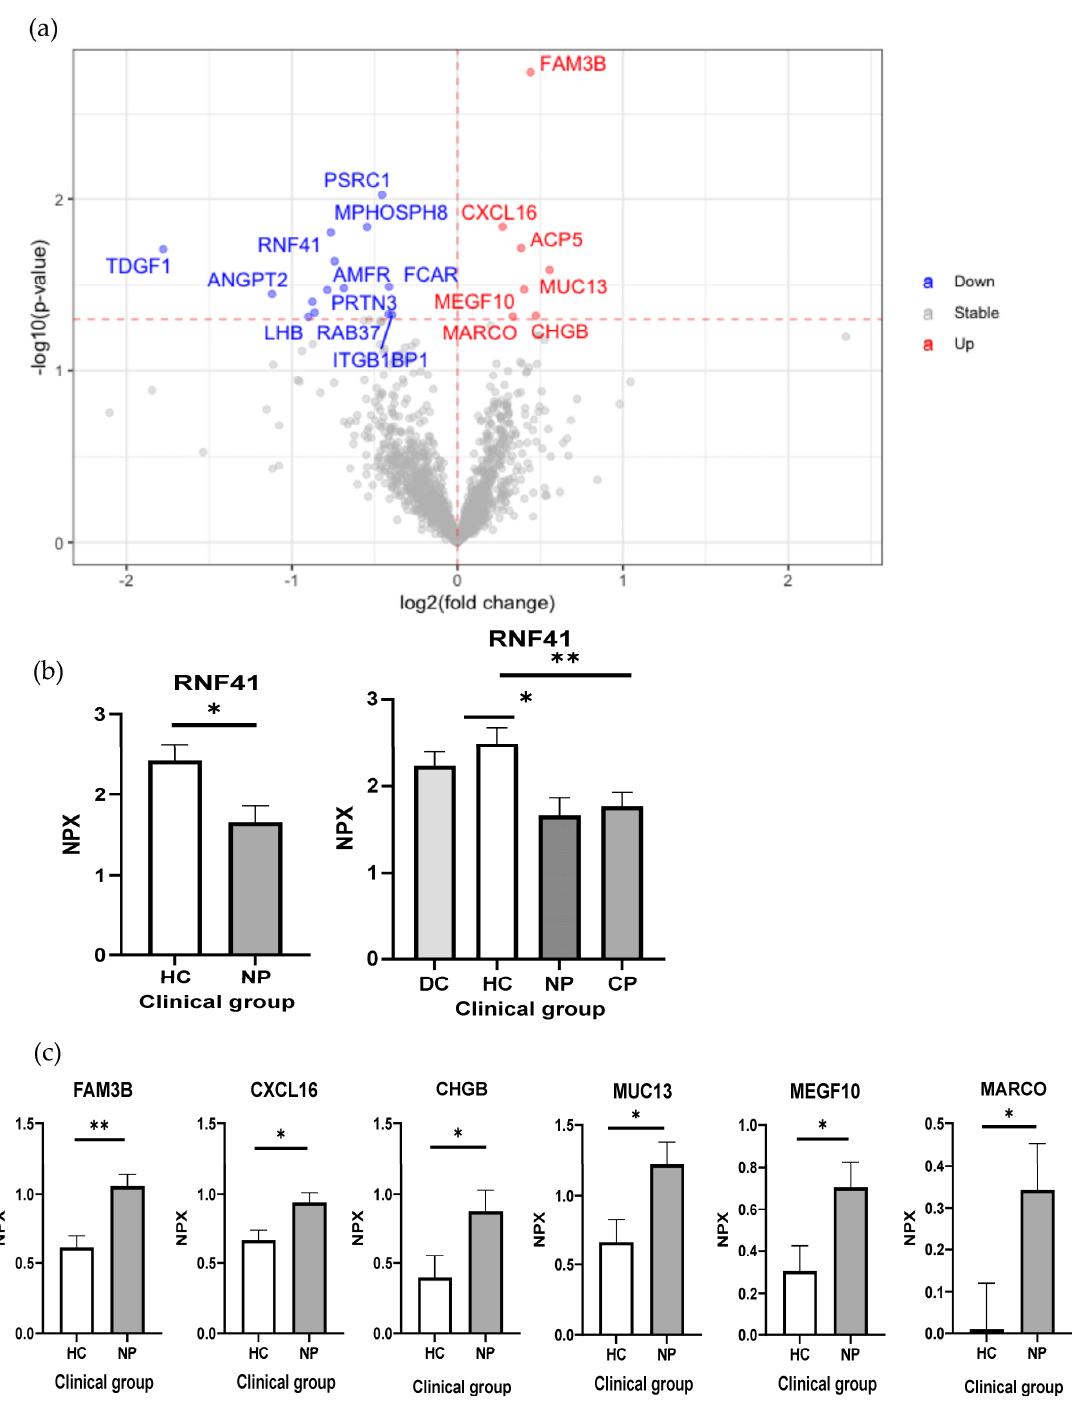
Figure 2. Reduced plasmas level of RNF41 is associated with SARS-CoV-2 infection. ( a ) Volcano plot of statistical significance against fold-change of proteins between patients without comorbidities and healthy controls. The red (upregulated in patients without comorbidities) and blue (downregulated in patients without comorbidities) dots indicate statistical DEPs; ( b ) bar plots with normal- ized protein expression of RNF41 among different clinical groups; ( c ) bar plots with normalized protein expression of FAM3B, CXCL16, CHGB, MUC13, MEGF10 and MARCO in patients without comorbidities and their respective healthy controls. * and ** indicate statistically significant with an adjusted p -value < 0.05 and <0.01, respectively. CP, comorbidities patient; DC, disease control; HC; healthy control; NP, non-comorbidities patient; NPX, normalized protein expression.